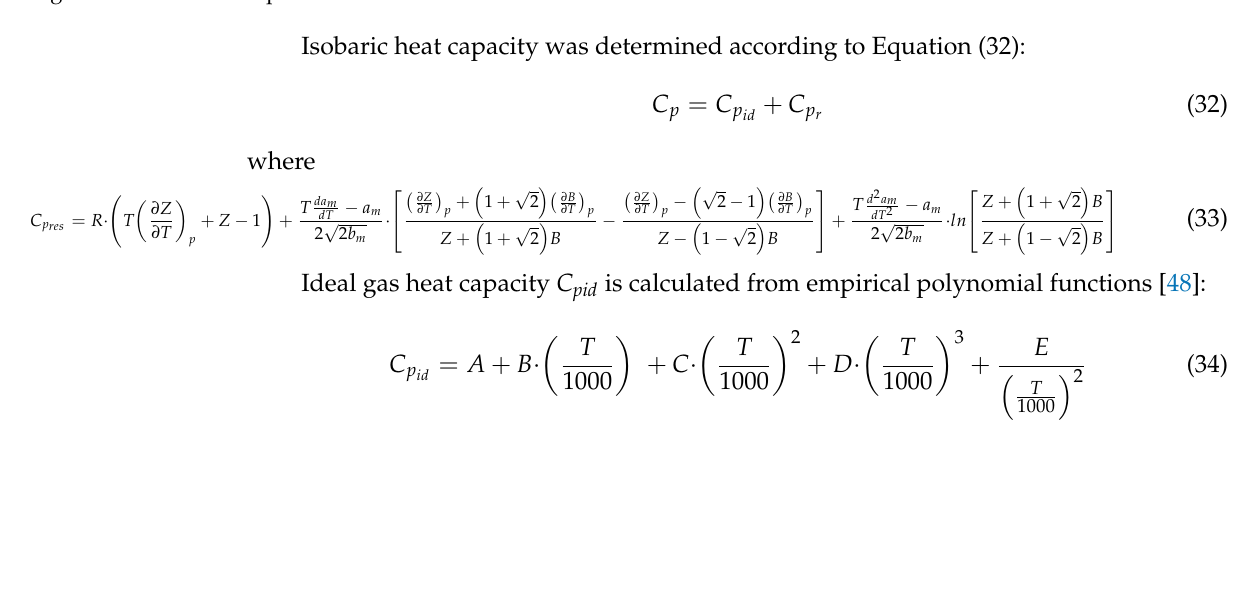
Figure 2. Change of the compressibility factor Z during the filling process of the composite tank (type IV) for the considered natural gas mixtures and